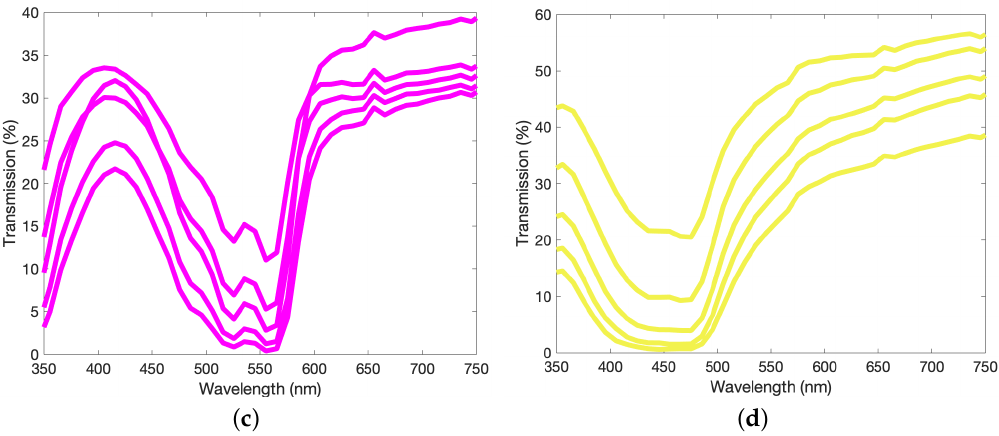
Figure 3. ( a ) Examples of five-step prints constructed from the CMY inks, varying in print height from 0.2 mm to 1 mm and printed onto a transparent glass slide. ( b – d ) Transmission values for the three pigments printed onto a transparent substrate, averaged over 5 nm intervals. These inks contain a pigment load of 0.037 wt%, 0.035 wt% and 0.035 wt%, respectively. The largest magnitude transmittance curve represents the smallest print height and the smallest magnitude transmittance curve represents the largest print height. Some overlaps in the orders occur due to defects arising in the print